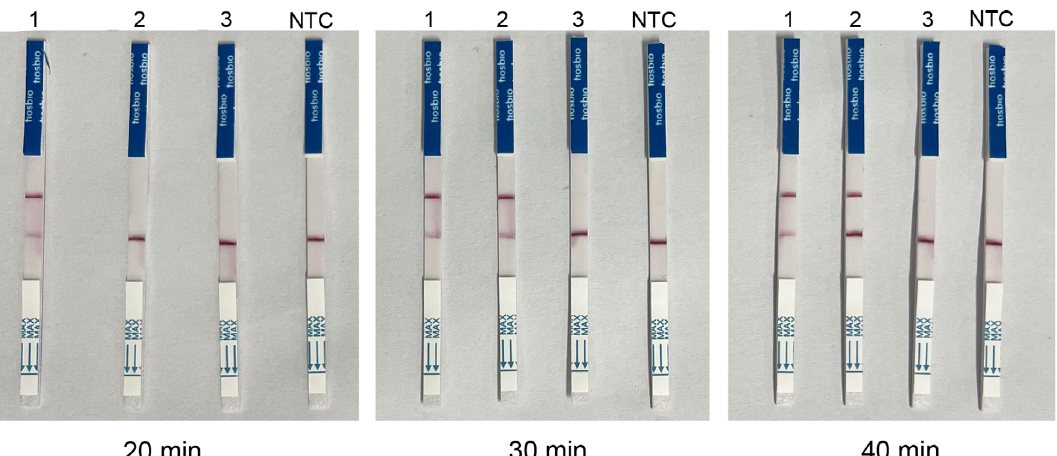
Figure 5. Optimization result of RAA-Cas13a-LFD ampli fi cation time. Strip: 1. 1 (cid:1) 10 (cid:3) 5 ng/ l L; 2. 1 (cid:1) 10 (cid:3) 6 ng/ l L; 3. 1 (cid:1) 10 (cid:3) 7 ng/ l L; NTC: negative control (ddH 2 O).